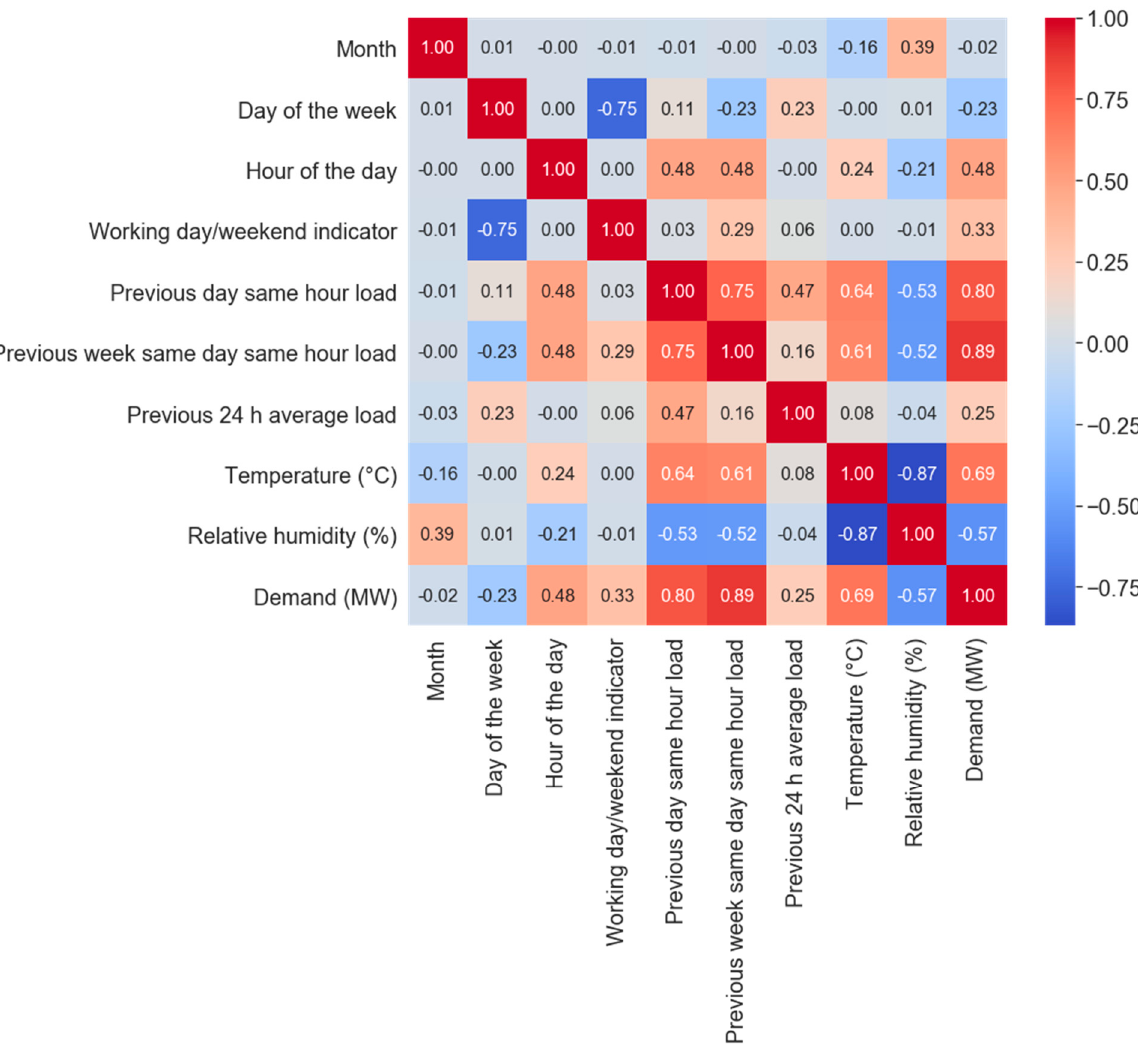
Figure 9. Correlation Heatmap.